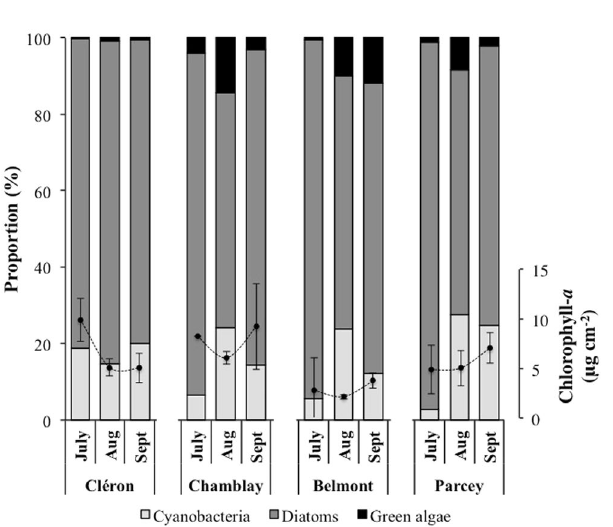
Figure 2. Spatio-temporal variation in the proportions of the main photosynthetic taxonomic groups in the Loue River biofilms estimated by microscopic cell counting (stacked histogram) and in chlorophyll- a concentrations (black circles). Values and error bars represent the means of the three replicates and the standard deviations, respectively, except for Chamblay in July, where only one sample was collected due to poor weather conditions. Abbreviations: Aug, August; Sept,